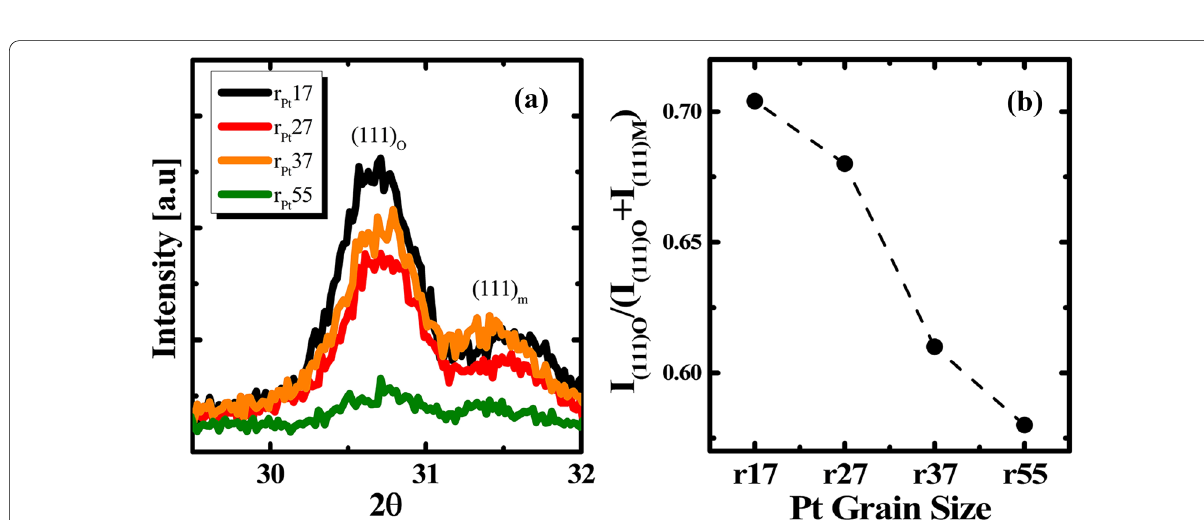
Fig. 4 a GIXRD pattern and b fraction of the orthorhombic phase of HZO on various grain size Pt